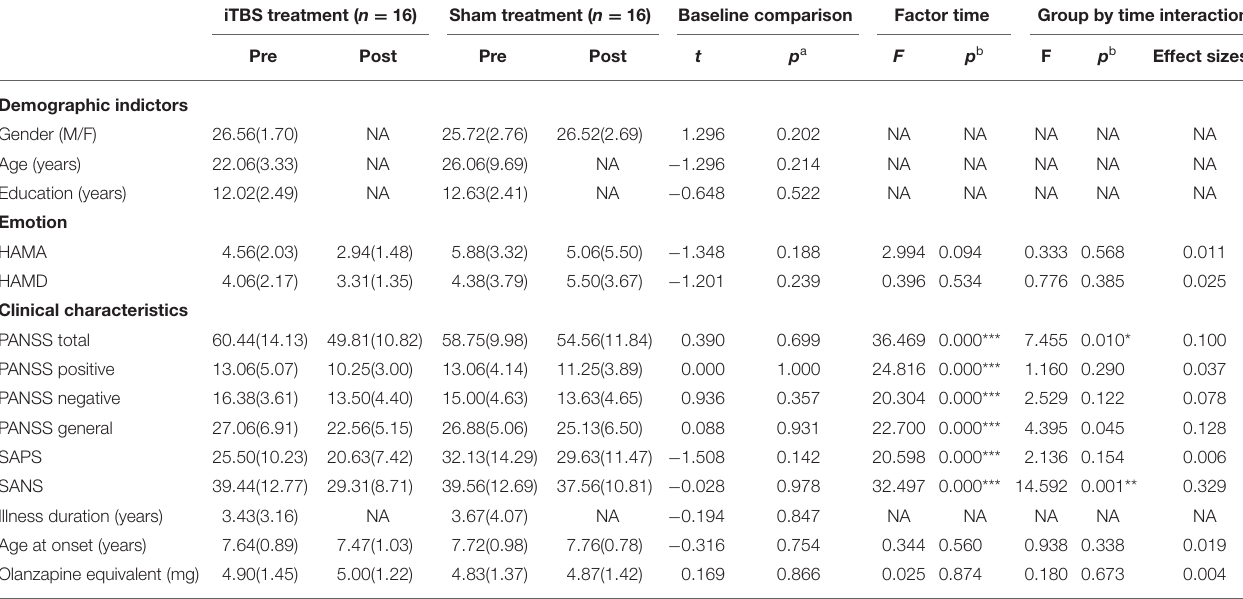
TABLE 1 | Planned 2 × 2 repeated measure ANOVA on over time (pre-TMS, post-TMS). iTBS treatment ( n = 16) Sham treatment ( n = 16) Baseline